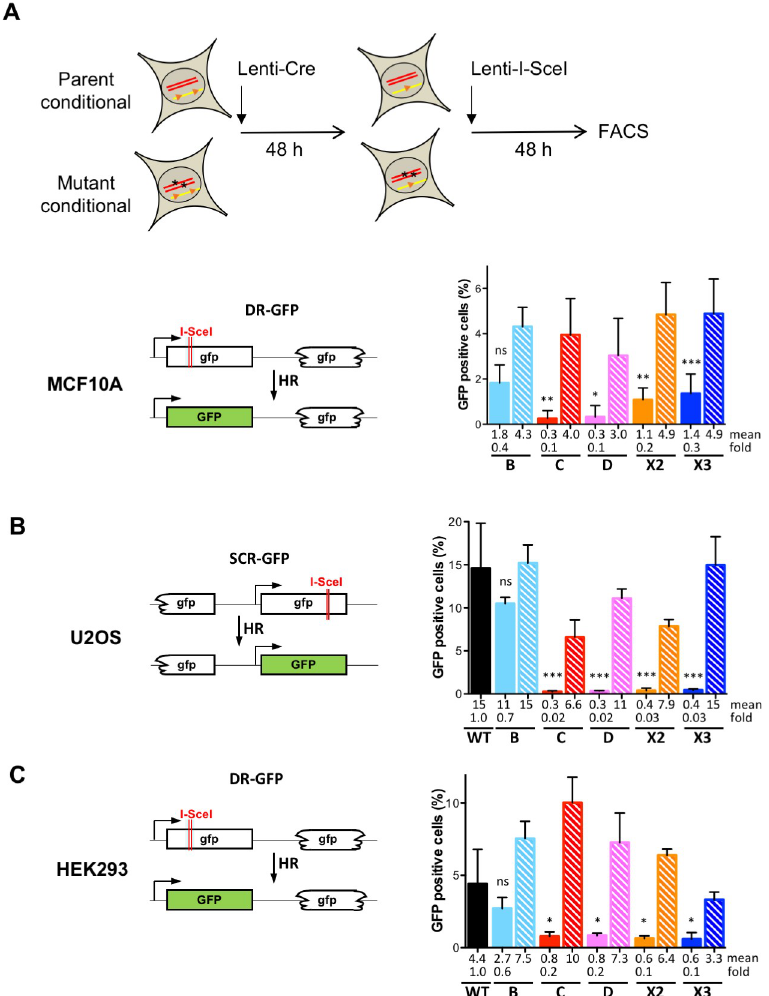
Fig 3. RAD51 paralog disruption leads to homologous recombination deficiency. (A) Schematics showing experimental scheme to transiently perform HR assay. Since RAD51 paralogs in MCF10A cells (except RAD51B) were inviable after Cre expression, the analysis was performed 2 days post-Cre infection when the mutant cells were still alive. Post-Cre mutant and parental cells were infected with I-SceI–expressing lenti-virus for 48 h. GFP+ cells were measured by FACS. Schematic of the I-SceI-inducible direct repeat recombination reporter integrated in the genome of MCF10A [43,81].Filled and hatched bars represent the mutant and parental cells, respectively. Data are presented as means +/- SD from at least three independent experiments. Differences between post-Cre mutant and parental cells were statistically analyzed using unpaired one-way ANOVA and Tukey’s test. � p < 0.05, �� p < 0.01, ��� p < 0.001, ns not significant. (B, C) Schematic of the I-SceI-inducible direct repeat recombination reporter integrated in the genome of U2OS [67] and HEK293 [84] cells. Cells were transfected with I-SceI-expressing plasmid and GFP+ cells were measured. Filled and hatched bars are for the mutant cells and the mutant cells stably complemented with a retroviral construct expressing the corresponding wild-type allele, respectively. Data are presented as means +/- SD from at least three independent experiments. Differences between mutant and wild-type cells were statistically analyzed using unpaired one-way ANOVA and Tukey’s test. � p < 0.05, �� p < 0.01, ��� p < 0.001, ns not significant. Comparisons between complemented and wild-type cells were respectively in U2OS and HEK293, B ns , C ��� , D ns , X2 ��� and X3 ns ; and B ns , C ��� , D ns , X2 ns and X3 ns (not indicated in the figure). Comparisons between complemented and mutant cells were respectively in U2OS and HEK293, B �� , C ��� , D ��� , X2 ��� and X3 ��� ; and B �� , C ��� , D ��� , X2 �� and X3 ns (not indicated in the